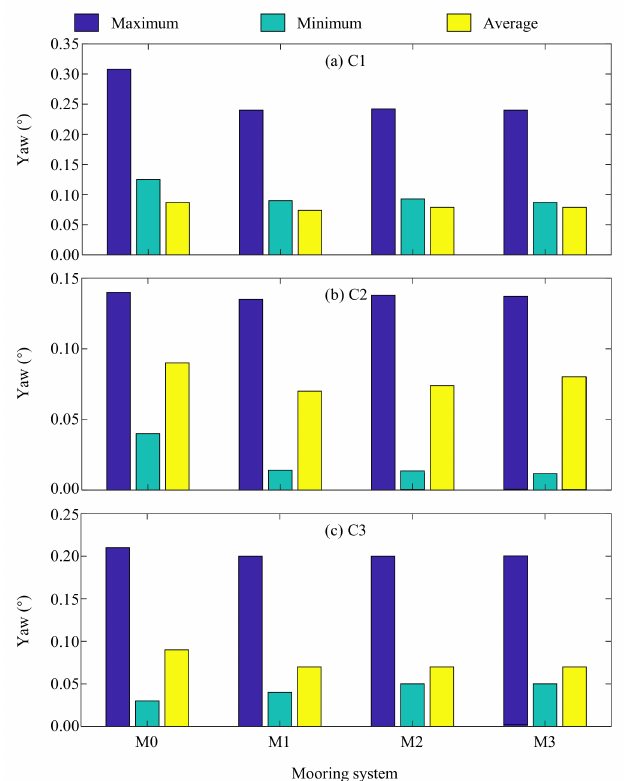
Figure 11. Maximum, minimum, and average values of wind turbine yaw movement time series with M0–3 when under: ( a ) C1; ( b ) C2; ( c )